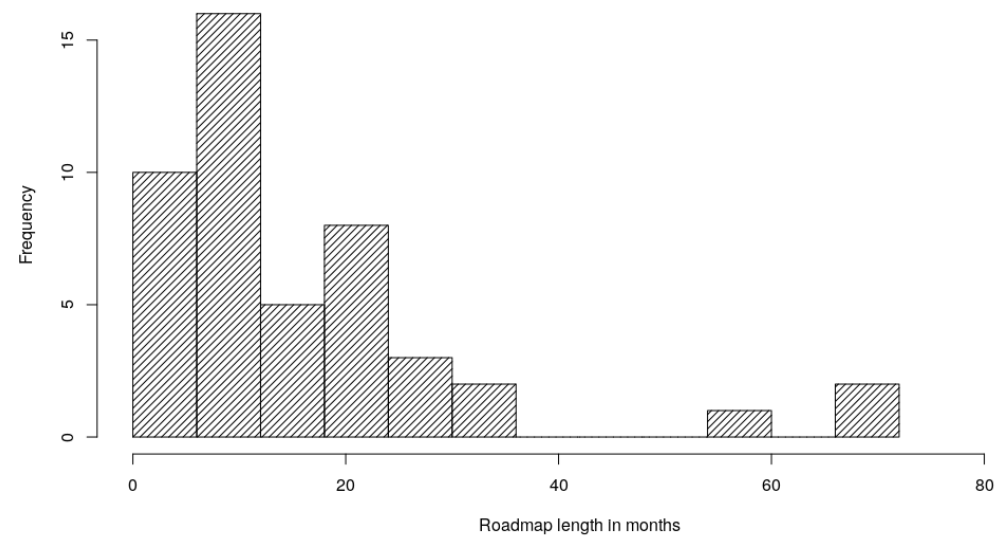
Figure 6. Histogram of the number of months of development described in the Agile ICO